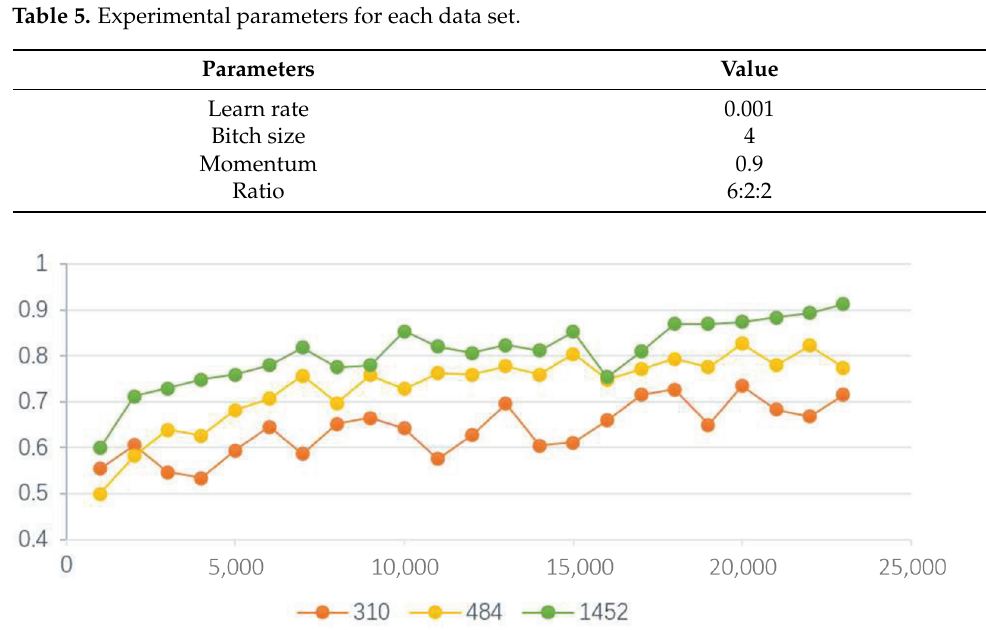
Figure 9. mAP of datasets with 310, 484, and 1452 samples under different